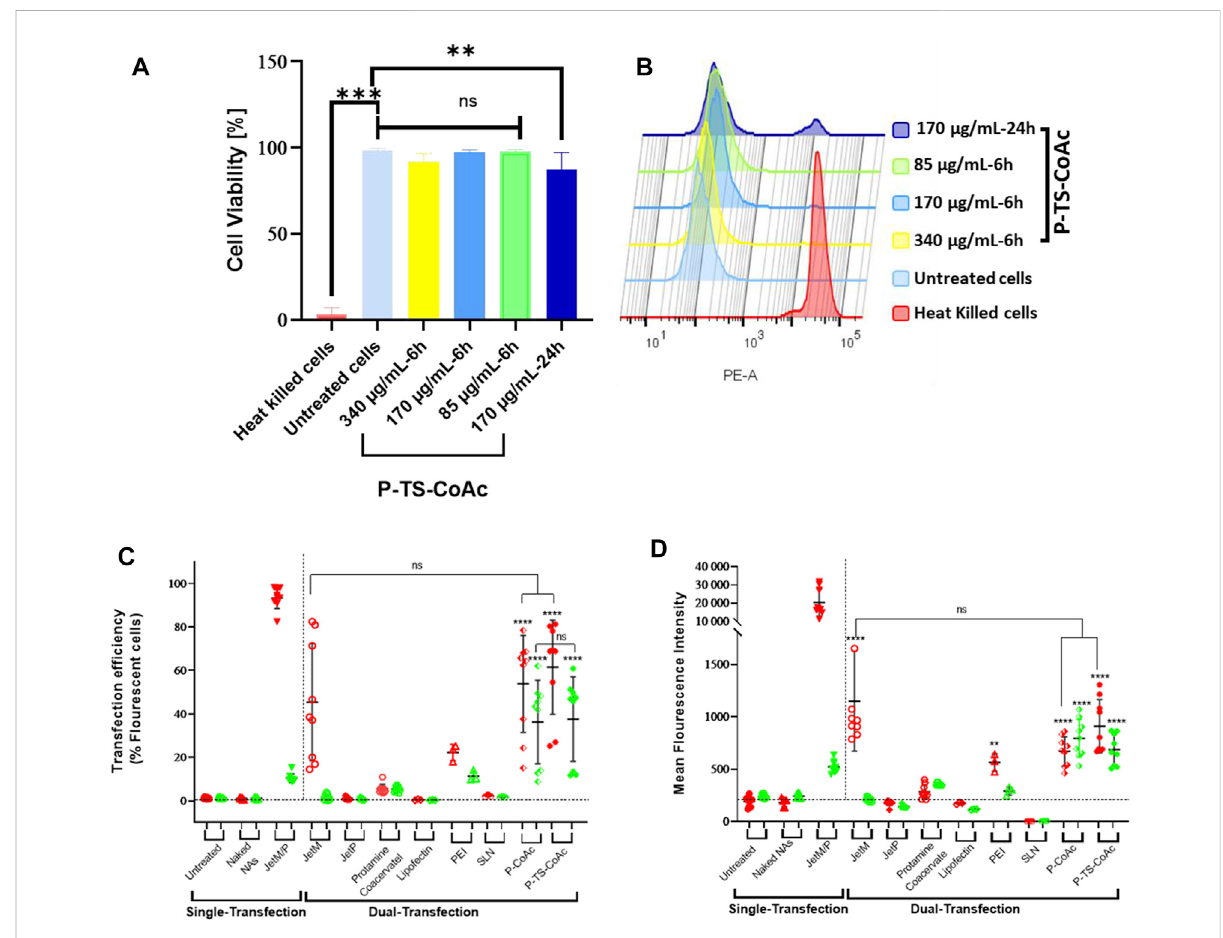
Cytotoxicity assay of P-TS-CoAc in DC2.4 murine dendritic cell line using fi xable dead stain (568/583) (A) % Cell viability following 6 h incubation of P-TS-CoAc (340,170 or 85 μ g/ml) or 24 h incubation of P-TS-CoAc (170 μ g/ml) (N = 3, n = 3); ** p < 0.01, *** p < 0.001, ns = not signi fi cant. (B) Fluorescence intensity (dead stain uptake) of cells following different treatments. Flow cytometric assessment of (C) transfection ef fi ciency and (D) mean fl uorescence intensity (MFI) of pAmCyan and mCherry loaded on P-CoAc and P-TS-CoAc, compared to single transfection using either JetMessenger for mRNA or JetPrime for DNA or double transfection using both mRNA and DNA with either JetMessenger, JetPrime, protamine sulfate ( N = 3, n = 3), Lipofectin, PEI or SLN ( N = 1, n = 3) coacervate in murine dendritic cell line DC2.4; ** p < 0.01, **** p